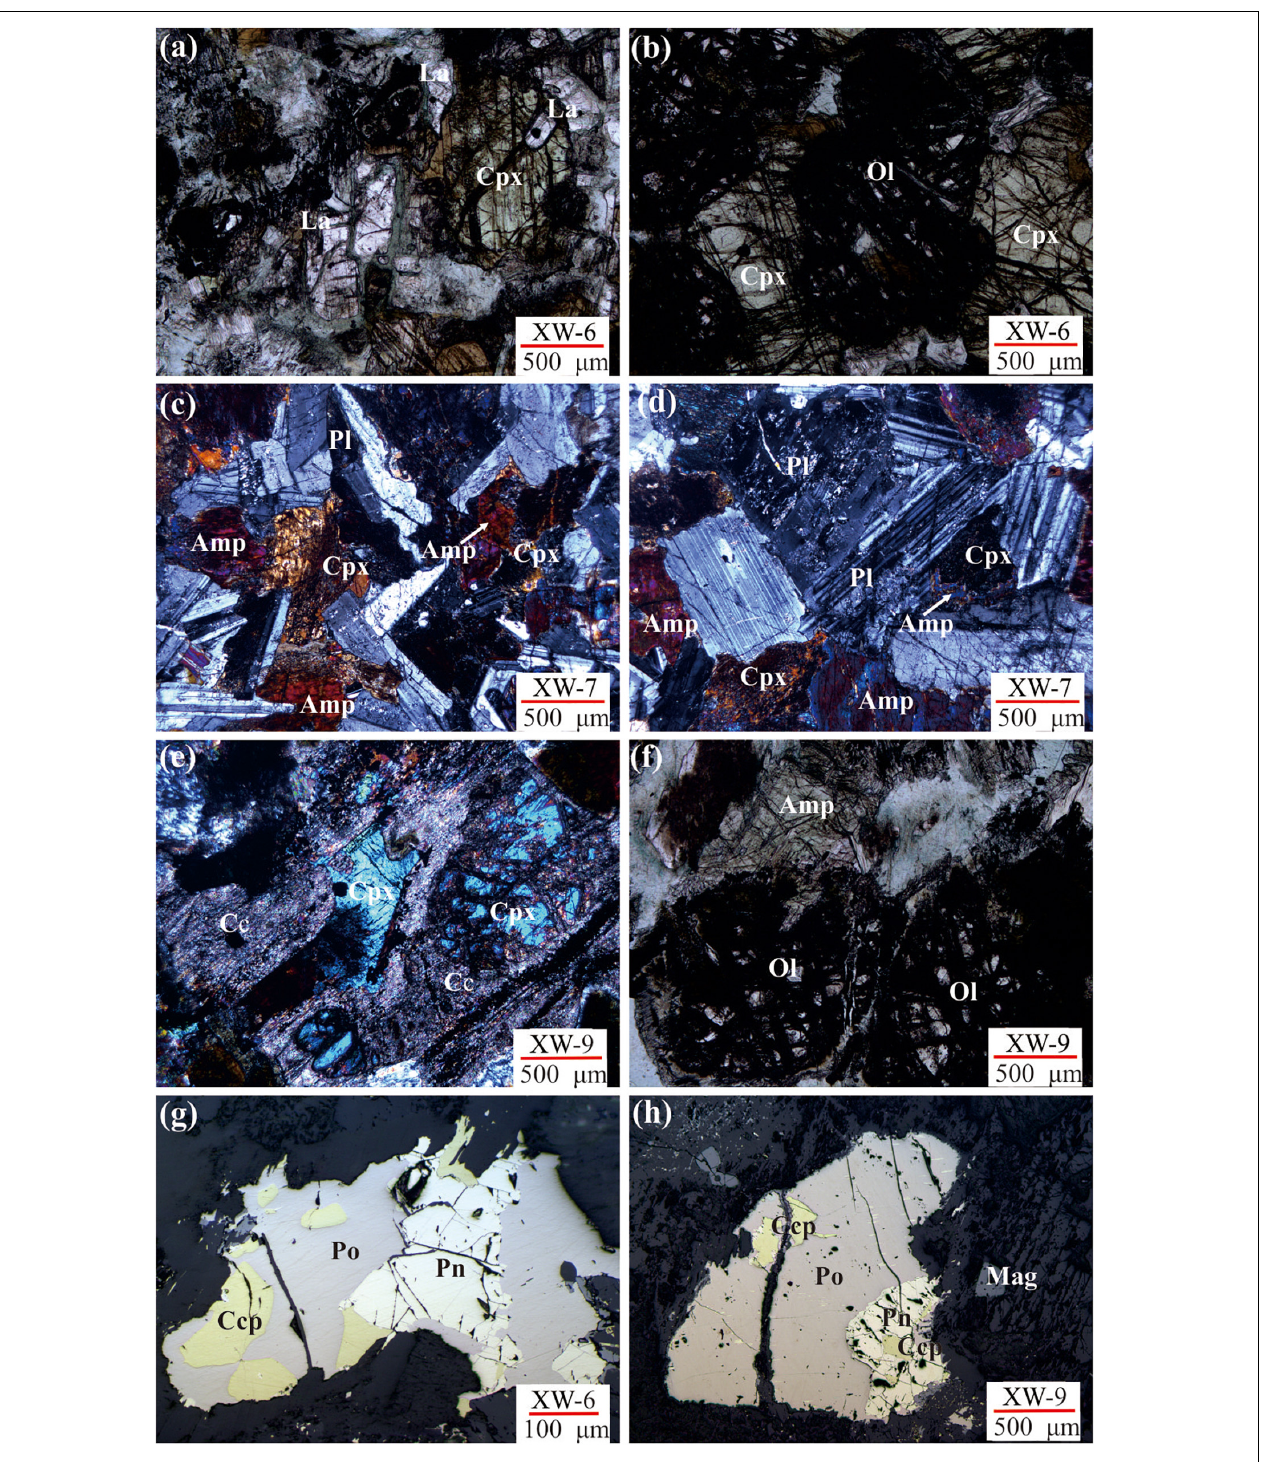
FIGURE 3 | Microphotographs of the Xiwanggou intrusions ( a,b,f : plain polarized, c–e : cross polarized, g,h : reflected light). (a) some euhedral labradorite clinopyroxene developed in an olivine gabbro sample; (b) Medium-grained and severely absorbed olivine surrounded by clinopyroxene in an olivine gabbro sample; (c,d) Euhedral clinopyroxene and plagioclase showing equigranular texture filled by fine-grained and interstitial amphibole in a gabbro sample. (e) Severe carbonation altered clinopyroxene in a gabbro sample; (f) Medium-grained and severely absorbed olivine surrounded by amphibole in an olivine pyroxenite sample; (g,h) the pentlandite, pyrrhotite, and chalcopyrite in mineralized olivine gabbros and olivine pyroxenites, respectively; Amp, amphibole; Cpx, clinopyroxene; La, labradorite; Ol, olivine; Pl, plagioclase; Pn, pentlandite; Po, pyrrhotite; Ccp, chalcopyrite; Mag, magnetite.